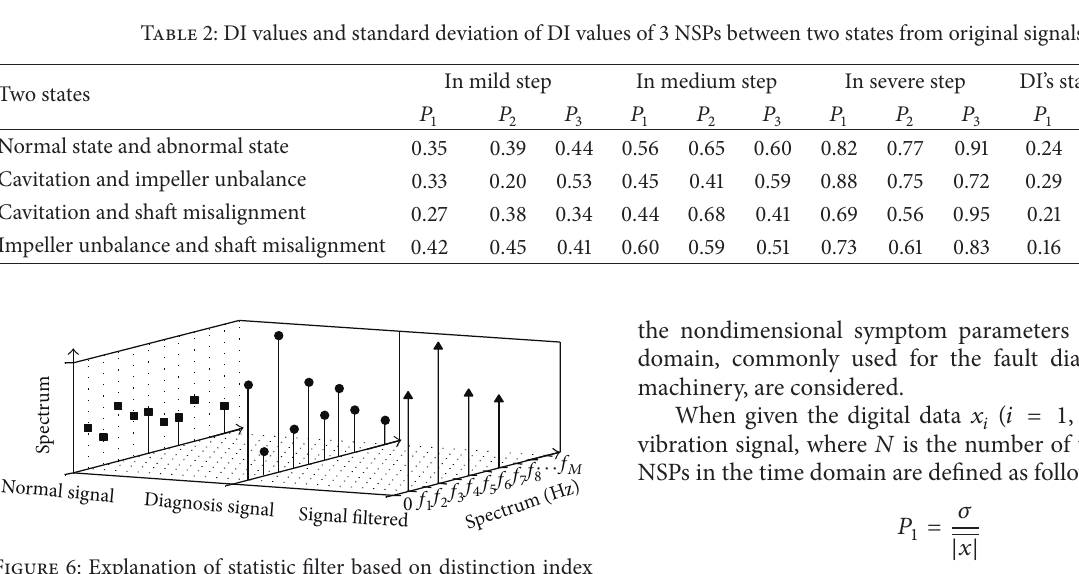
Figure 6: Explanation of statistic filter based on distinction index (DI) of